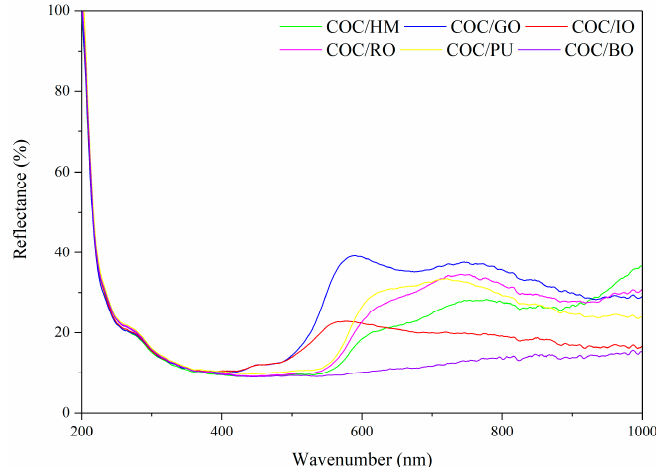
Figure 2. Light reflectance of the COC composites filled with different earth pigments.